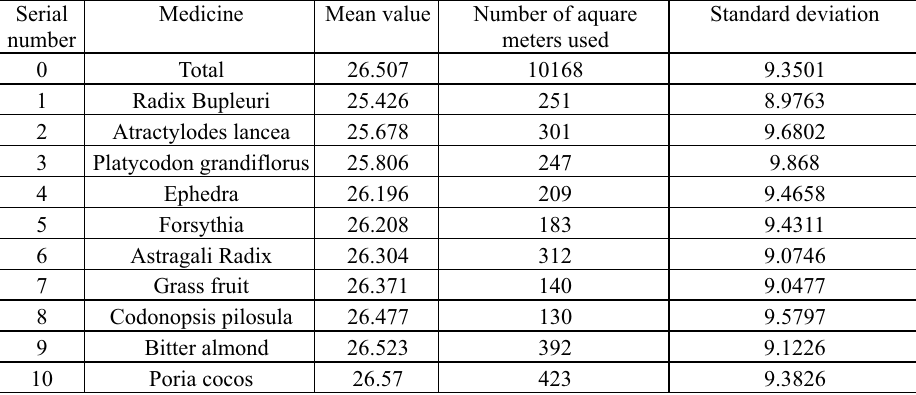
Table 3. Comparison of mean value of turning negative time of core drugs.